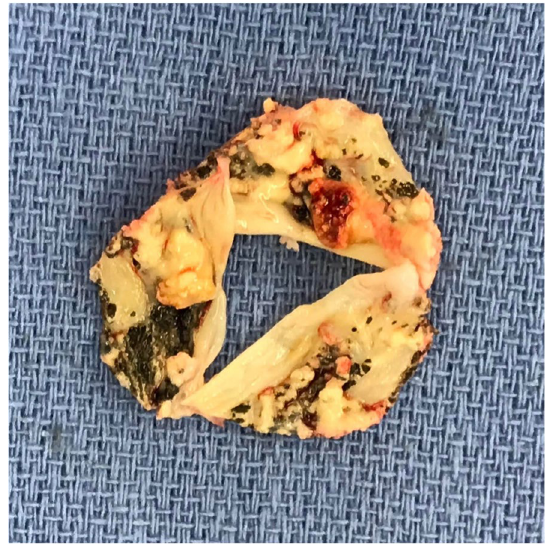
Fig. 1 Macroscopic view of the resected aortic valve leaflets with black pigmentation